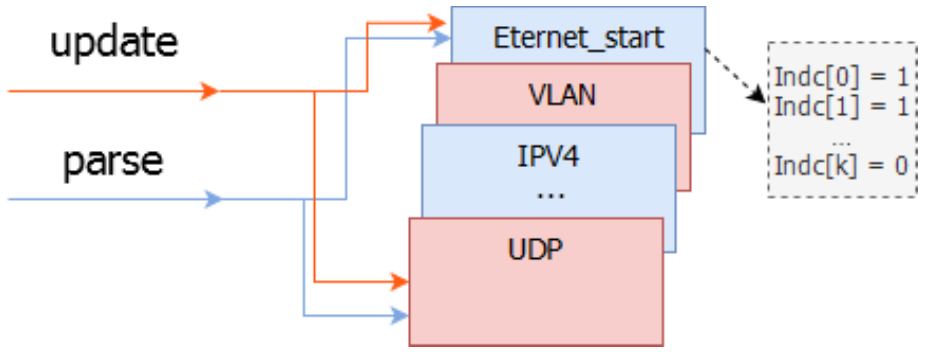
Figure 3. Diagram of the queue.